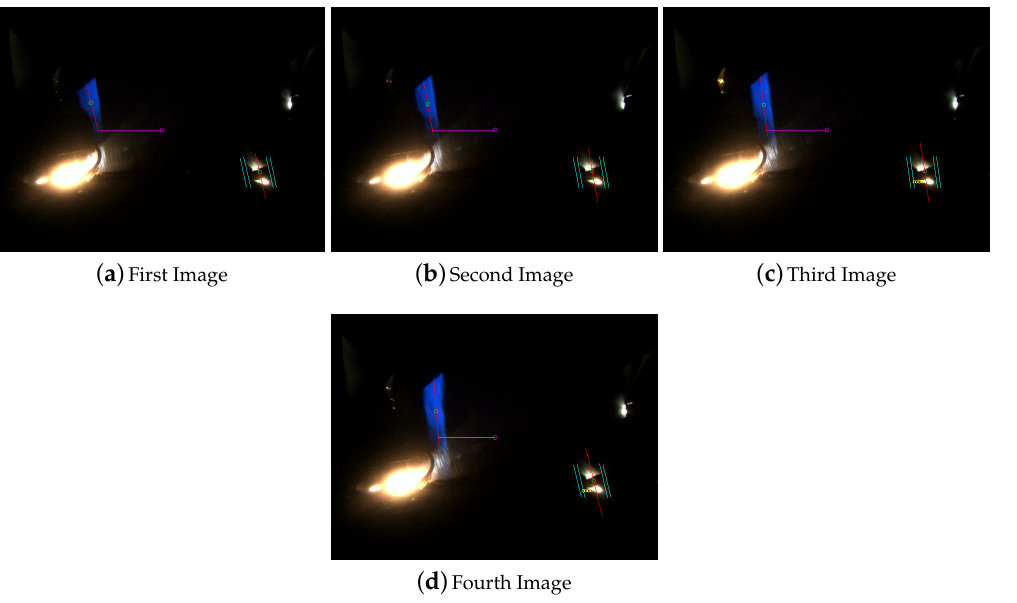
Figure 19. Successful visual mark identification with a false detection of the visual mark 17.